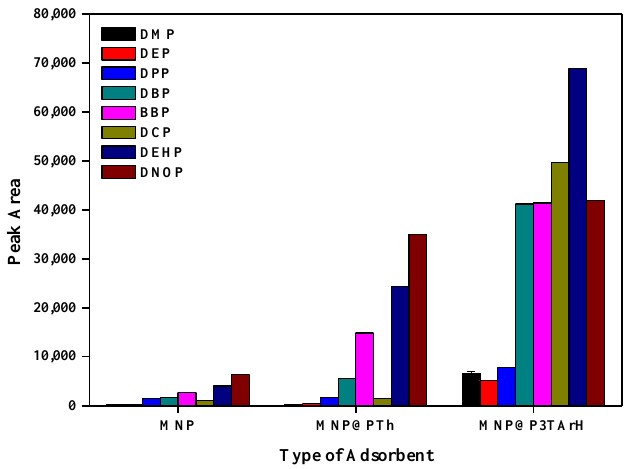
Figure 5. Comparison of MNP@P3TArH with naked MNP and MNP@PTh for the extraction of targeted